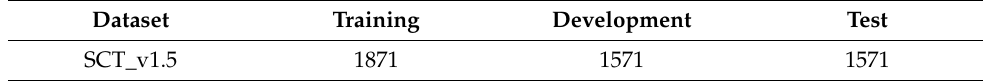
Table 5. Statistics of the datasets used in our experiments.